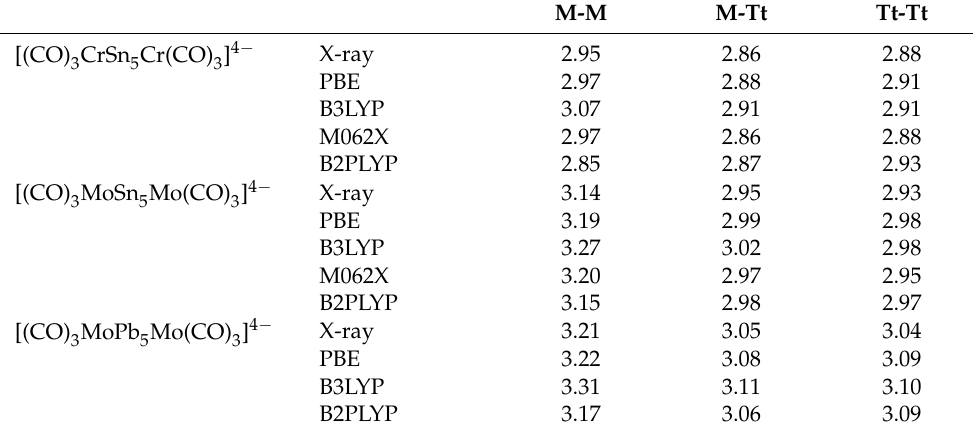
Sn (CO) ] – is expanded (Top: measured spectrum. Bottom: 2 5 6